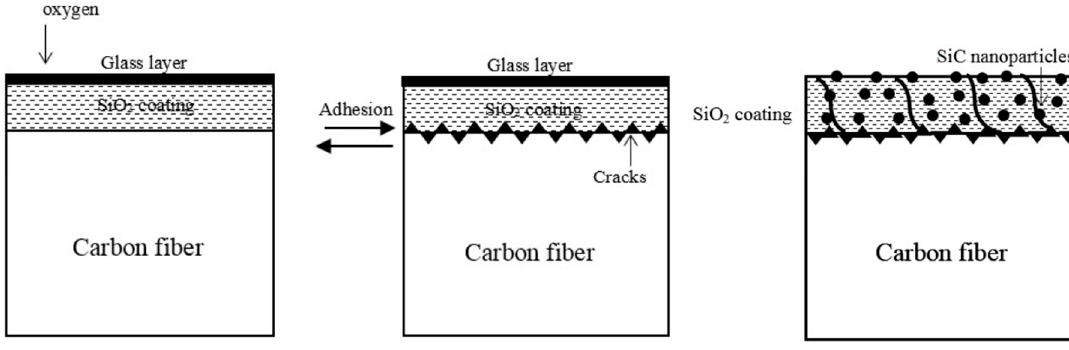
Figure 8. Oxidation mechanism of coated CF.